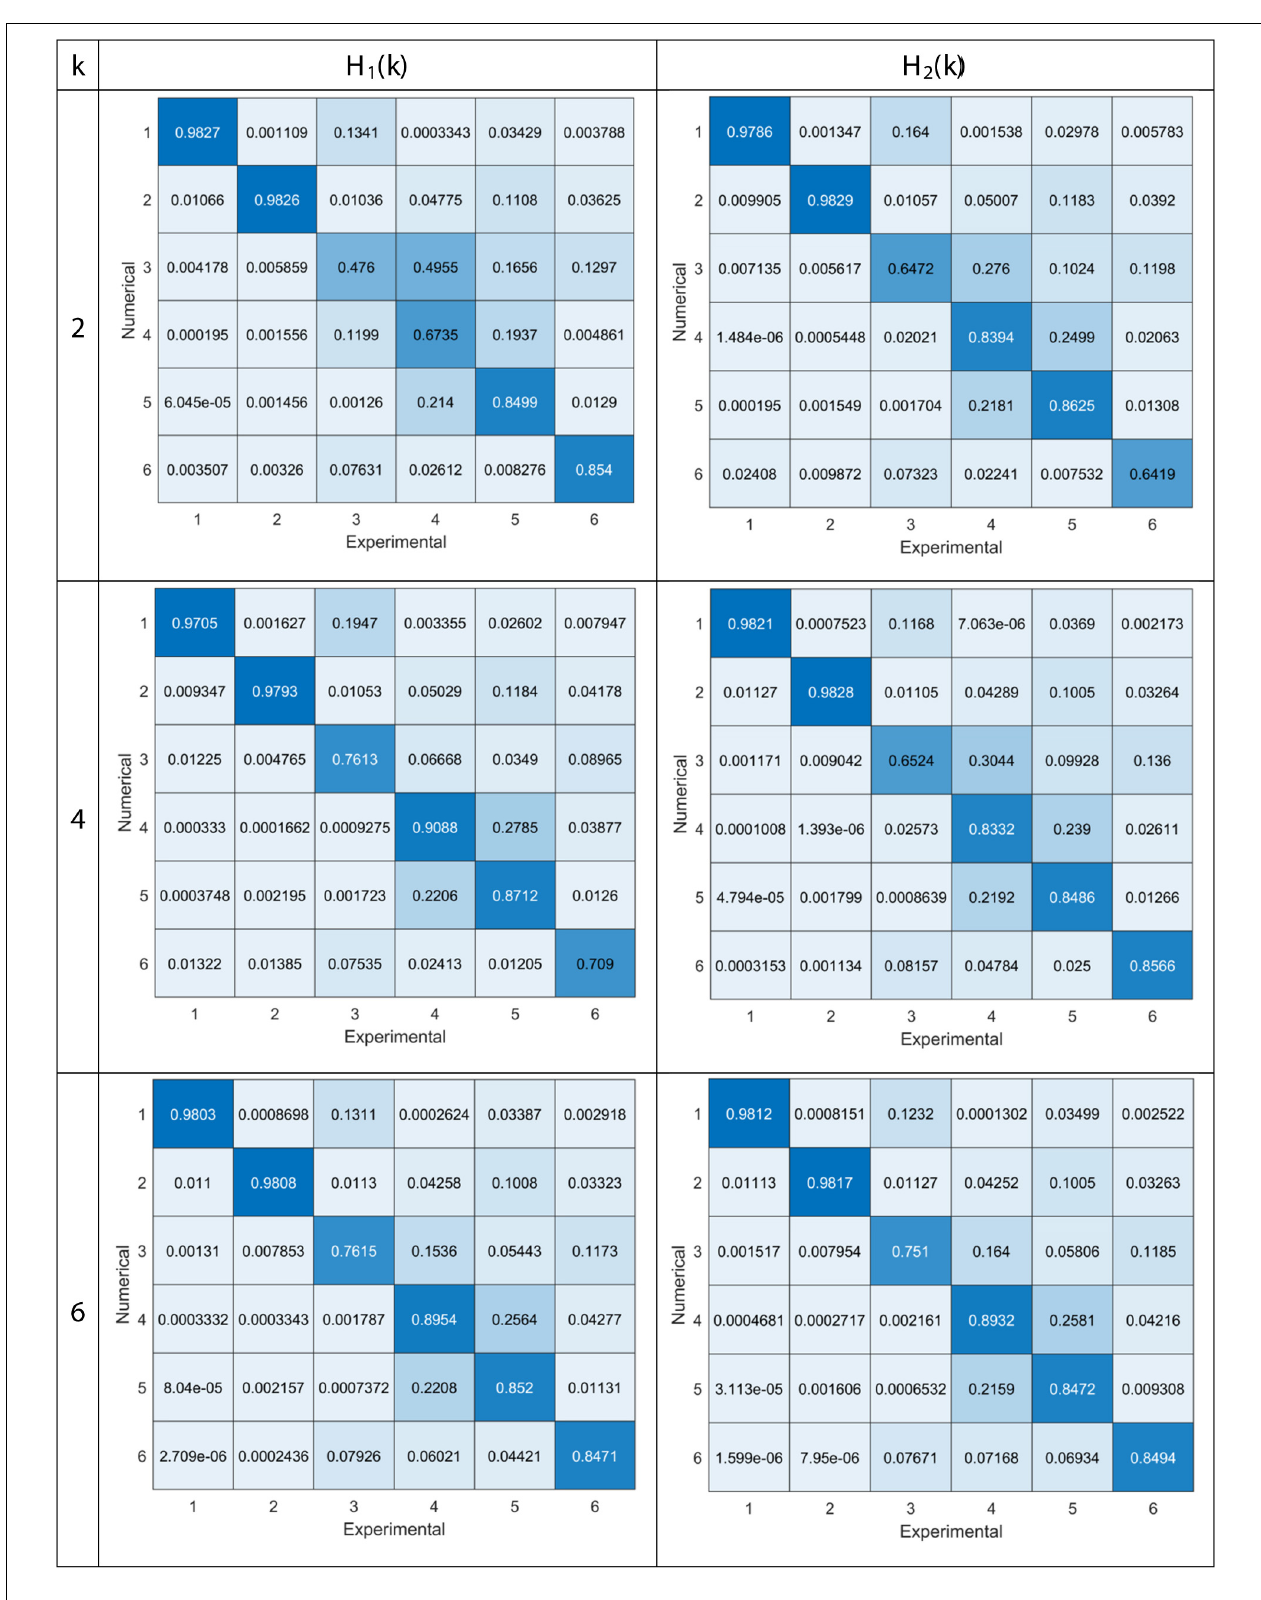
FIGURE 6 | MAC between experimental and numerical mode shapes (numerical results vs experimental ones).